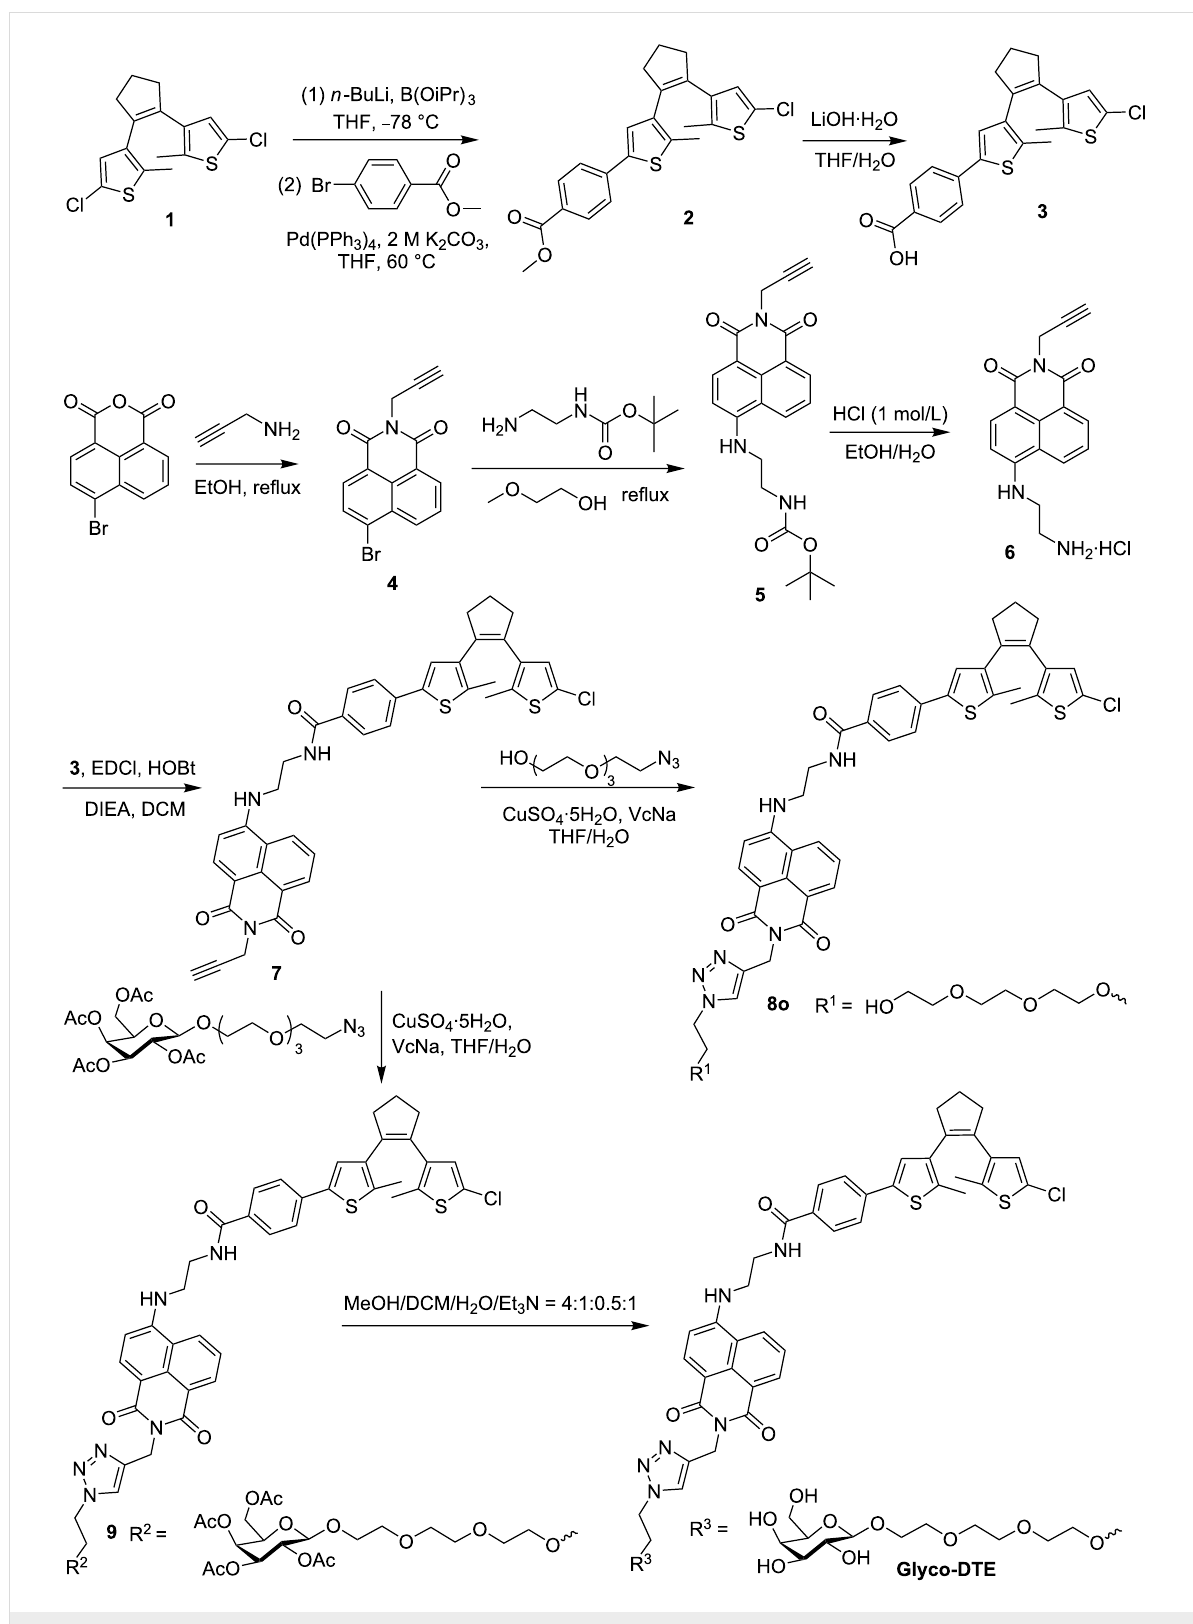
Scheme 2: Synthetic route to dithienylethene fluorescence reporters Glyco-DTE and 8o . VcNa: sodium